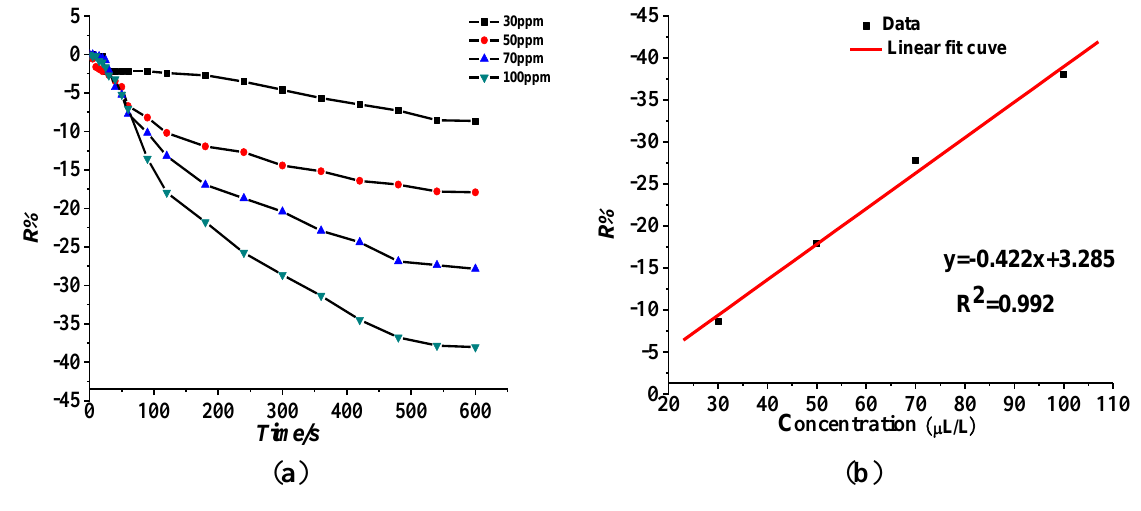
Figure 9. Response of the Pt-doped TiO 150 °C operating temperature. ( a ) Response of the sensor’s gas-sensing characteristics to different concentrations of SO gas